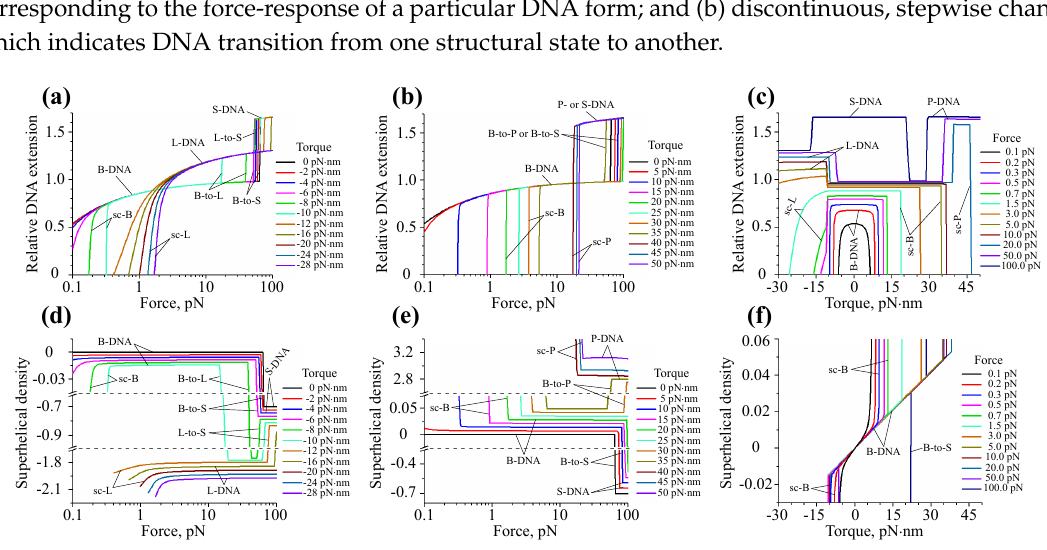
Figure 4. Structural stability of DNA under various mechanical constraints. ( a,b ) DNA force-extension ( f ) , and ( d,e ) force-superhelical density curves, σ τ ( f ) , calculated at different values of curves, z τ 0 0 the applied torque ( τ = τ 0 ). Panels (a,d) and (b,e) display results obtained for negative and positive torques, respectively. Abrupt changes in the behavior of the DNA force-extension curves presented on panels (a,b) mark the DNA transitions from B-form into alternative L-, P- or S-DNA structures, which are denoted by the B-to-L, B-to-P, B-to-S and L-to-S tags. The graphs on panels (d,e) show that these transitions are accompanied by a drastic change of the DNA superhelical density due to the large difference in the relaxed linking numbers of the corresponding DNA forms. ( c ) DNA torque-extension ( τ ) , and ( f ) torque-superhelical density curves, σ ( τ ) , at different values of the applied curves, z f f 0 0 force ( f = f 0 ). At f 0 < 0.5 pN, all torque-extension curves have symmetric profiles with respect to both positive and negative torques, while at larger forces ( f 0 ≥ 0.5–0.7 pN), this symmetry breaks due to B-DNA switching into alternative L- and P-DNA structures. In panels (a–c), the DNA extension is normalized to the total contour length of DNA in B-form. The following abbreviations are used to indicate different DNA states and structural transitions in the above plots: sc-B, sc-L and sc-P, supercoiled B-, L- and P-DNA, respectively; B-to-L, B-to-P, B-to-S and L-to-S, structural transitions between the respective DNA